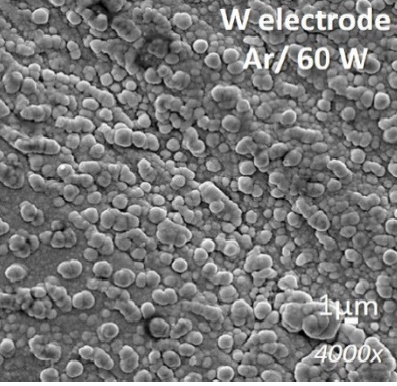
Figure 11. Margin zone_SEM images of W surface electrodes exposed to Ar-MD.